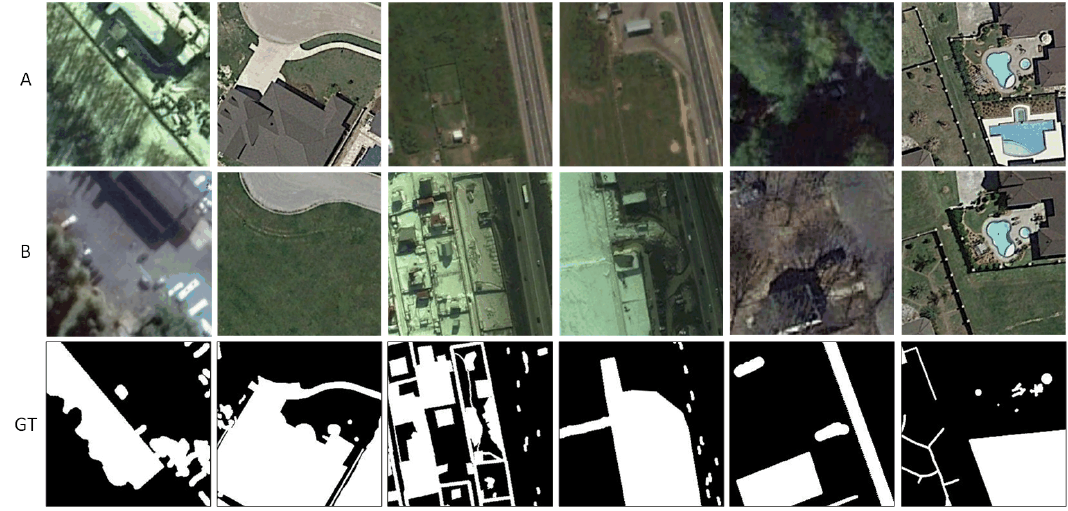
Figure 4. Illustration of samples from LEBEDEV. (A) and (B) indicate the bi-temporal image pairs. GT indicates the